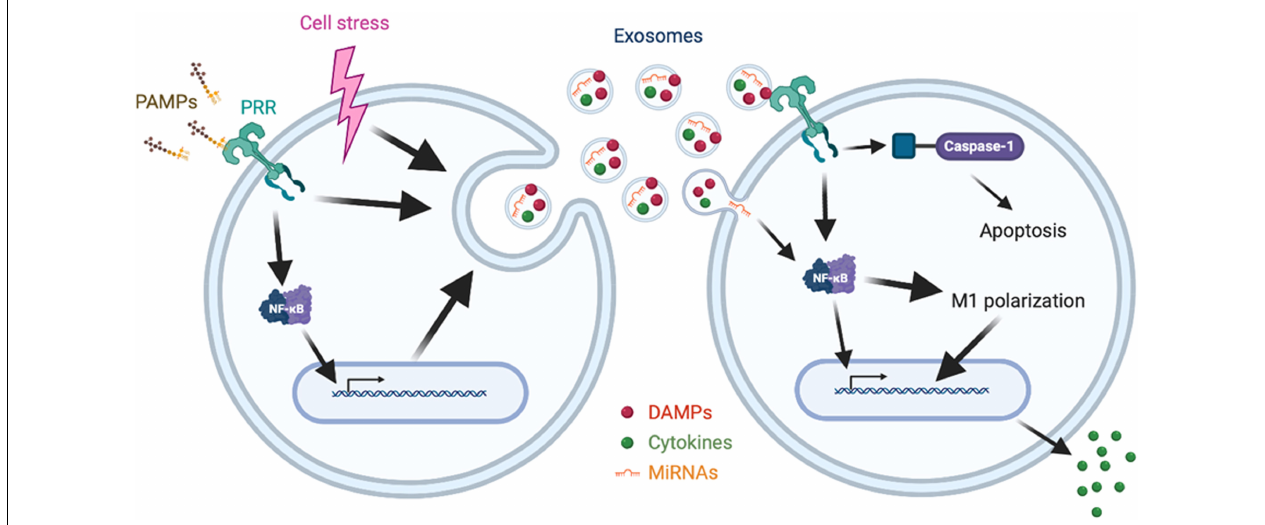
FIGURE 1 | Synopsis of release and impact of exosomes in sepsis. Cellular signaling initiated by PAMPs-PRRs interaction or cell stress promotes the release of exosomes enriched with cytokines, DAMPs, and miRNAs. The released exosomes induce cellular signaling via PRRs, NF- κ B or caspase-1, leading to apoptosis, M1 polarization, and cytokine release. TABLE 1 | Exosomal DAMPs and their impact on inflammation. DAMPs in exosomes Stimuli Interacting